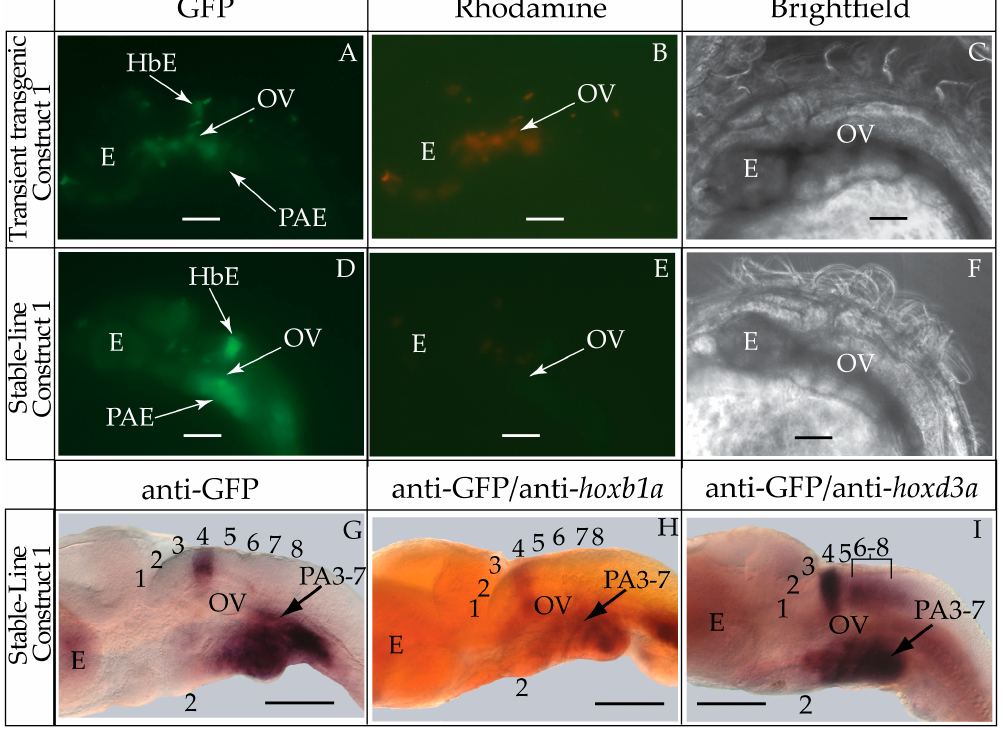
Figure 3. Transient ( A – C ) and stable-line ( D – I ) transgenic data from the medaka